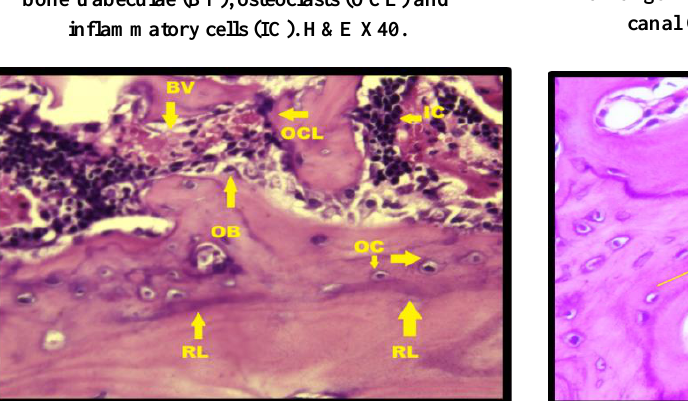
Figure (6 ): RS group at 4-weeks showing mature bone (osteon formation) by regularly arranged osteocytes (OC) around Haversian canal (HC) and Osteoblasts (OB) seen riming haversian canal